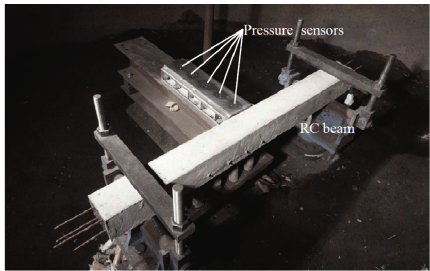
Figure 14: Experiment of simply supported beam structure subjected to near-field blast load [19]. Table 1: Experimental cases and parameters